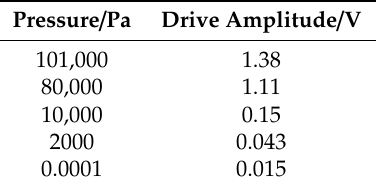
Table 2. AGC drive amplitude vs. pressure.